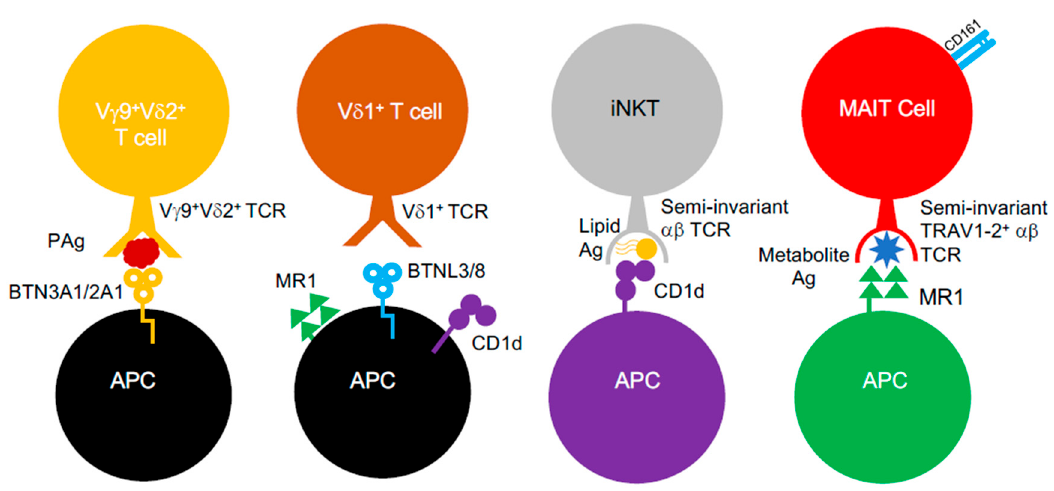
Figure 1. Unconventional αβ and γδ T cells. Unconventional αβ and γδ T cells populations and known interactions between their TCRs, the antigens they target and the MHC-like molecules involved.